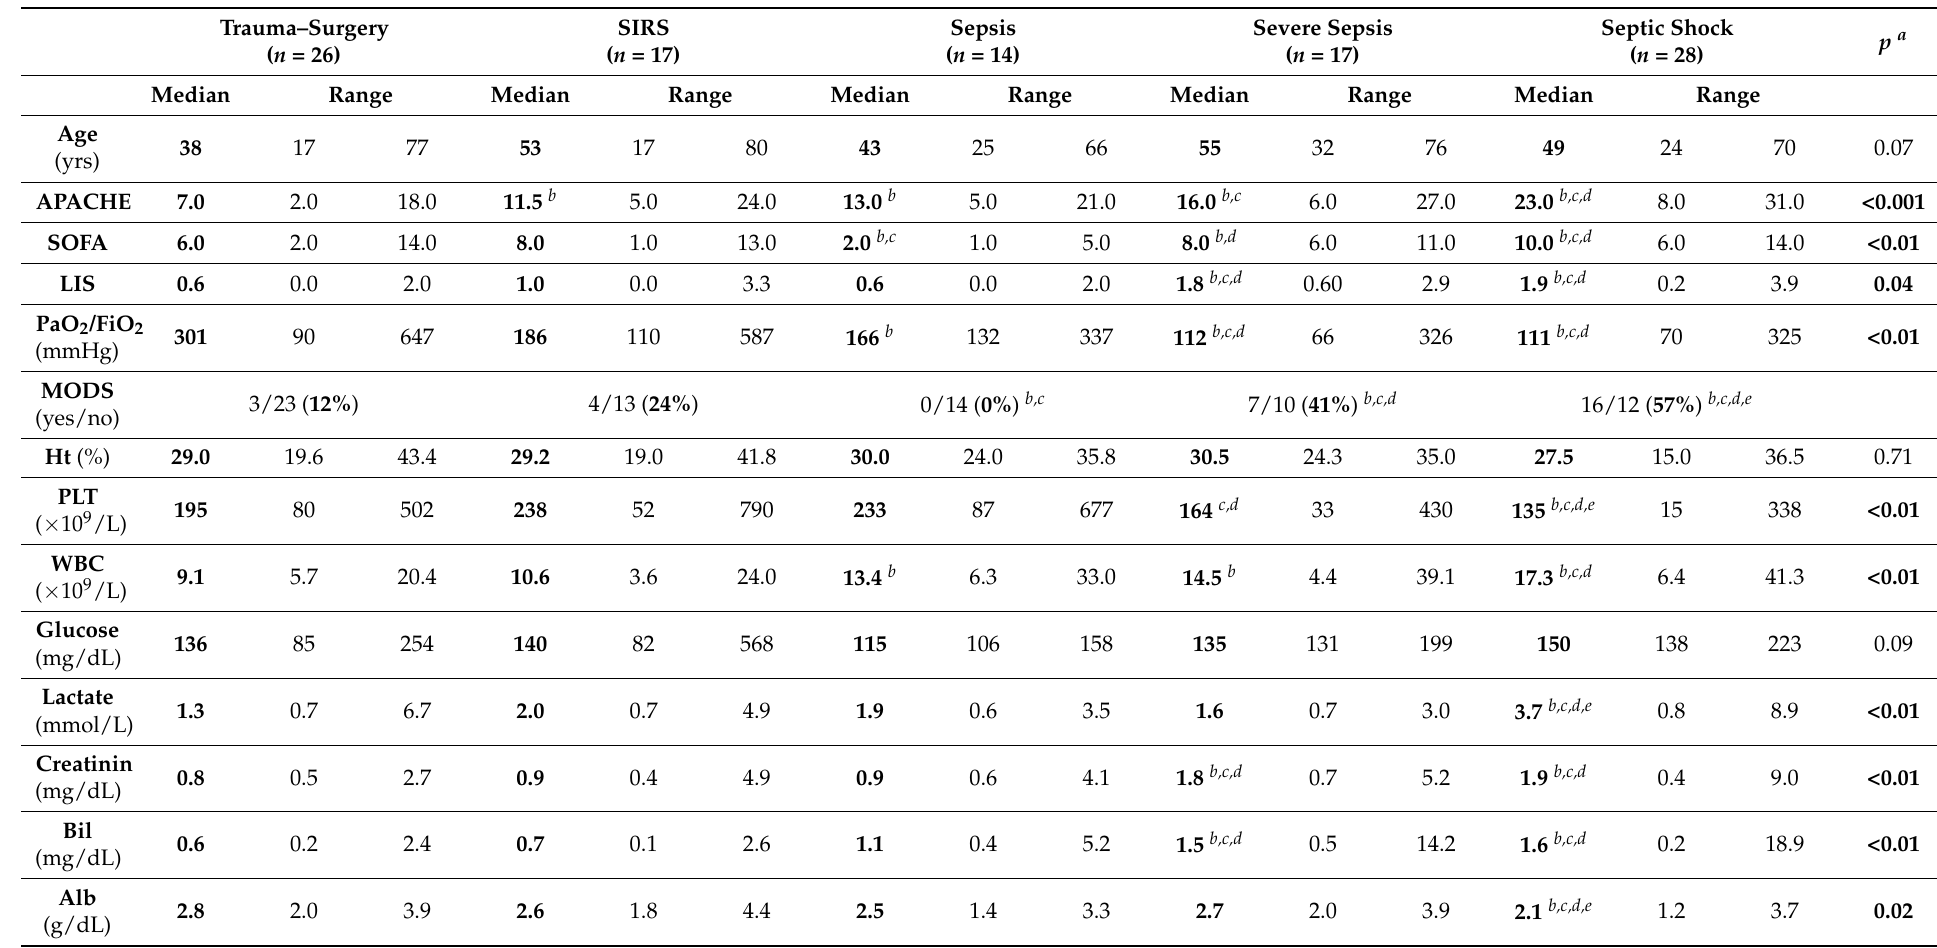
Table 1. Clinical and laboratory characteristics of patients on intensive care unit (ICU)